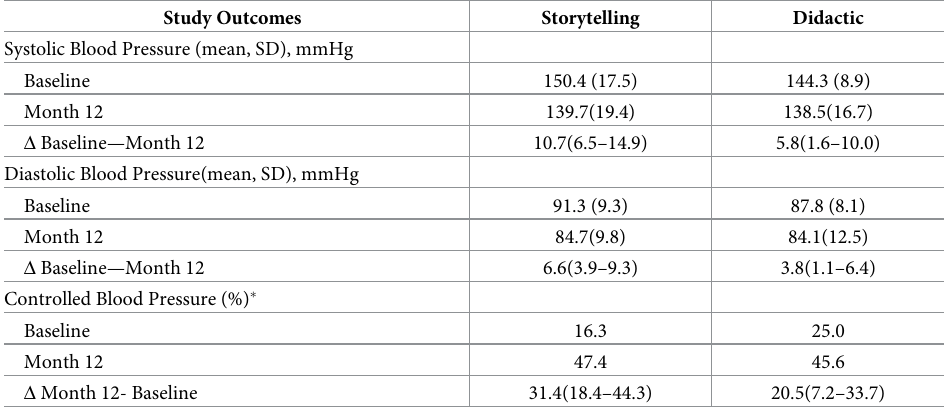
Table 3. Improvement Over-time (95% CI) in Blood Pressure Findings after Exposure to Storytelling and Didac- tic Interventions § . Study Outcomes